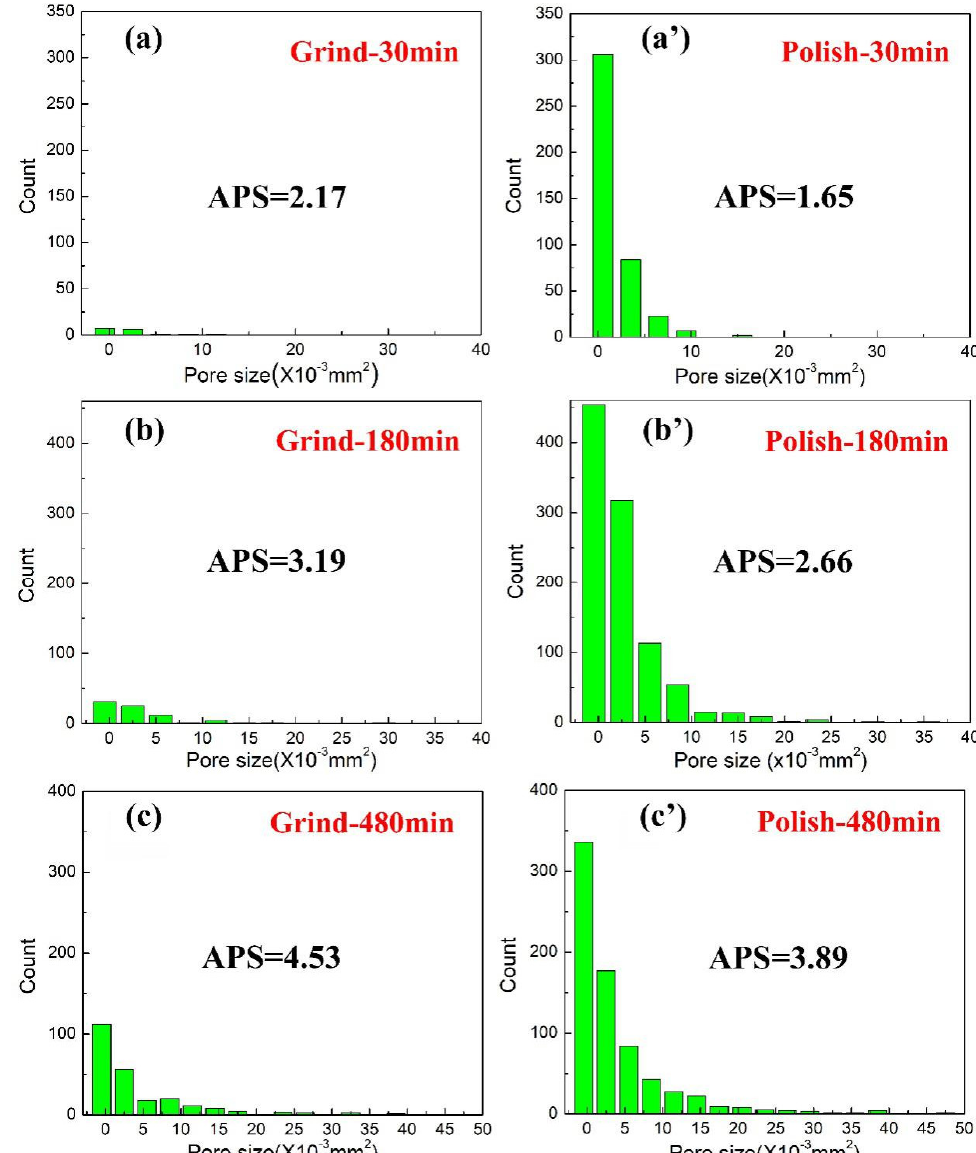
Figure 10. Histogram of the pore area along the cross section at the same distance from the grinded surface and the polished surface: ( a–c ) 0.2 mm from grinded surface and ( a’–c’ ) 0.2 mm from polished surface. APS: average pore size.